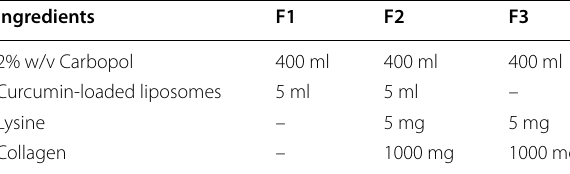
Table 1 Formulations F1–F3 and their varying